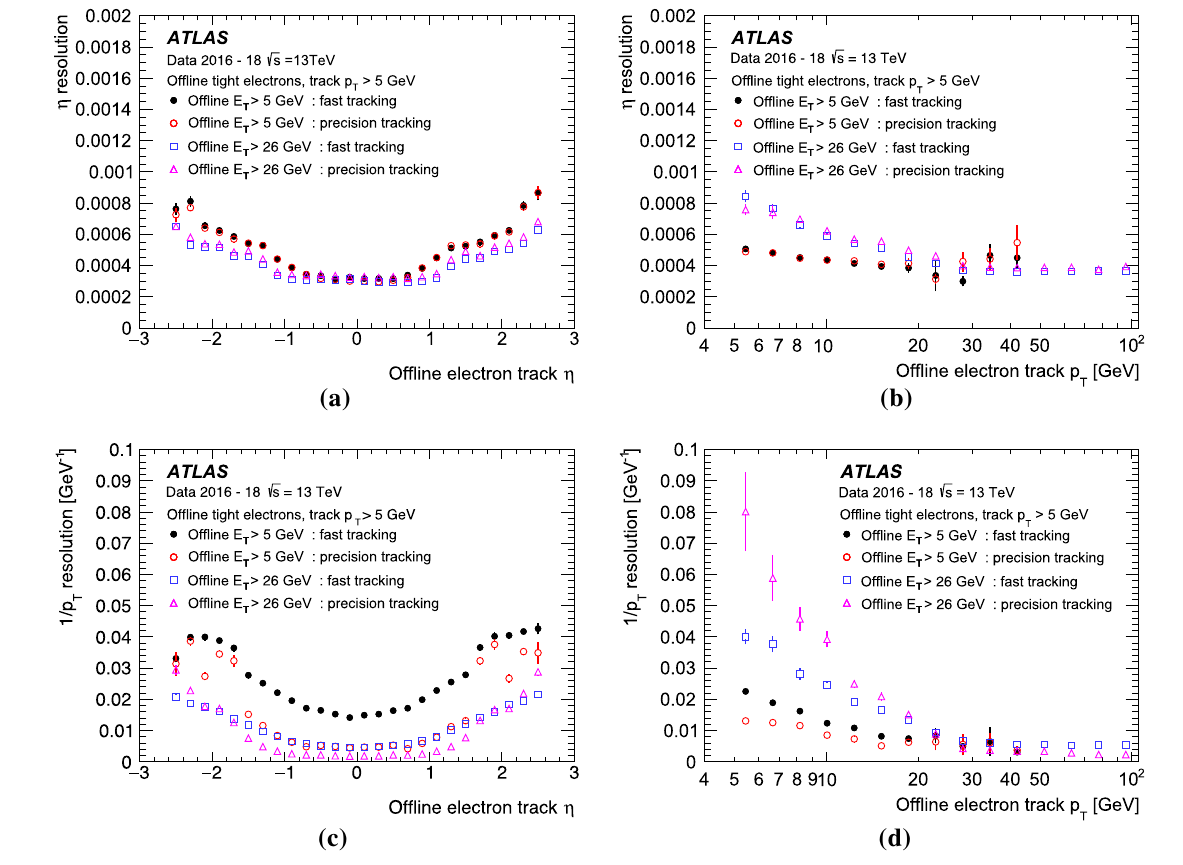
Fig. 24 The resolution for pseudorapidity and inverse trans- verse momentum as a function of offline track pseudorapid- ity and transverse momentum. The resolutions are shown for